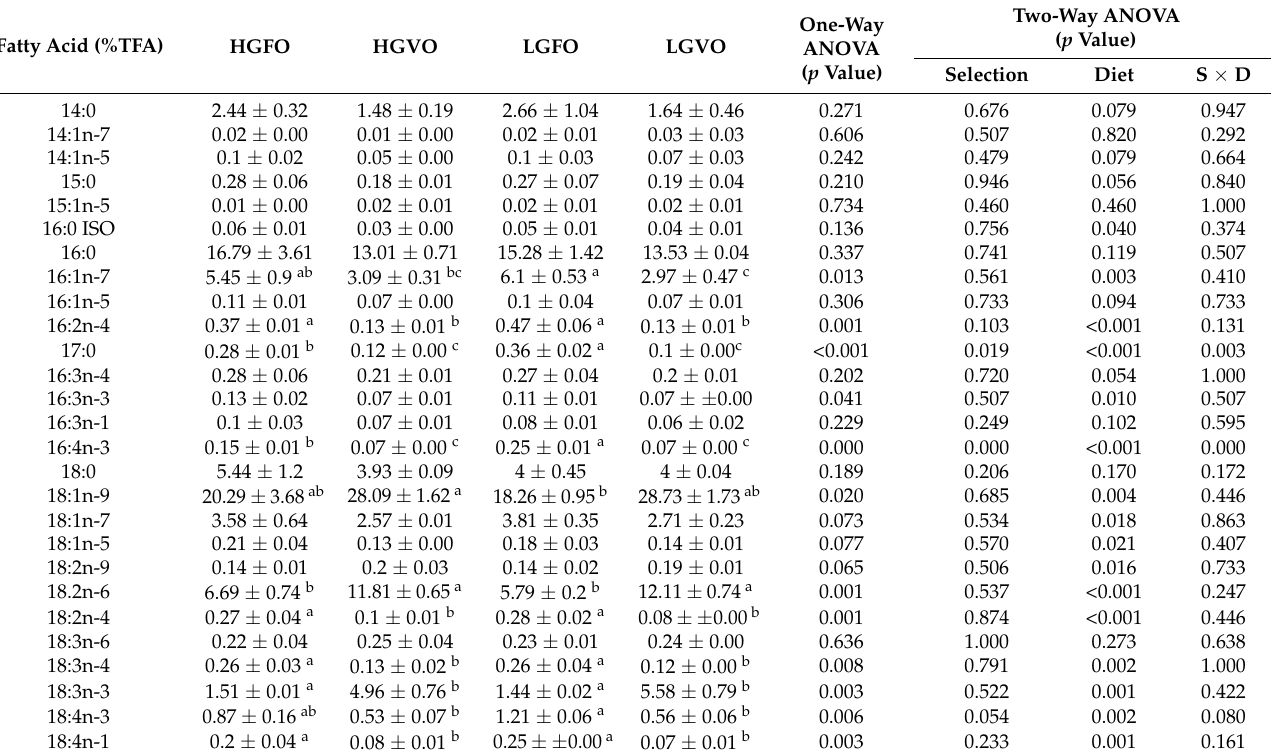
Table 14. Fatty acid composition (% total fatty acids) of eggs of gilthead sea bream broodstock selected for high (HG) or low (LG) growth and fed with either FO or VO diet over three months of reproductive season (n = 2 for all the broodstock group).